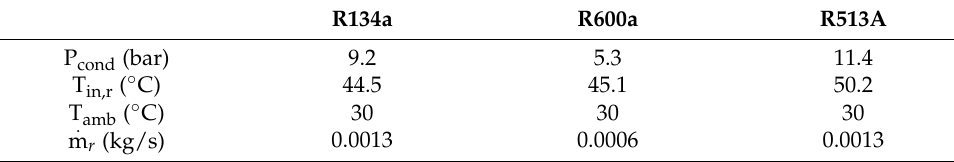
Figure 2. Input − output model structure of the multilayer wire-on-tube condenser. Figure 2. Input−output model structure of the multilayer wire-on-tube condenser. Table 2. Operating condition for refrigerants R134a, R600a, and Table 2. Operating condition for refrigerants R134a, R600a, and R513A.